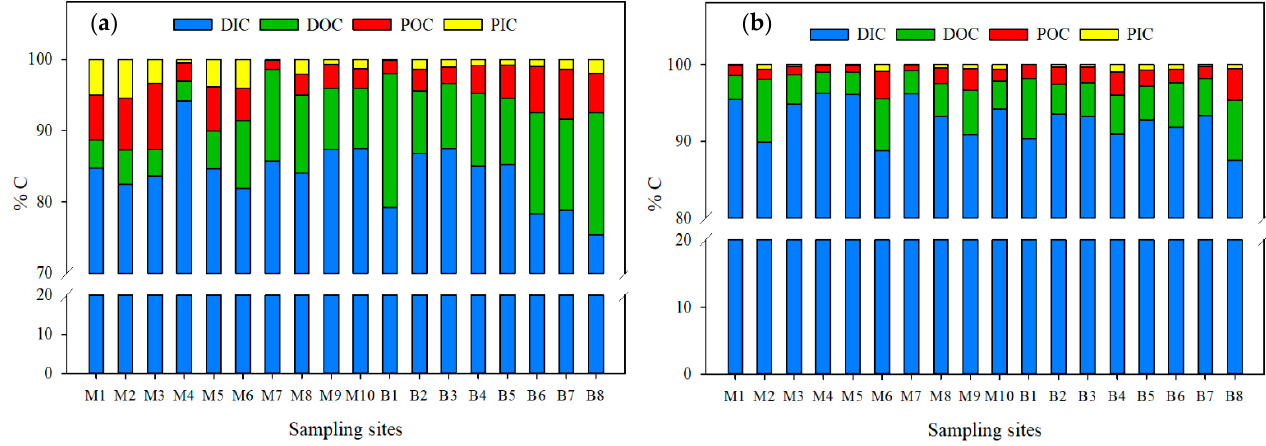
Figure 7. Percentage variations in C chemical fractions in the Usumacinta River during the ( a ) rainy and ( b ) dry seasons.